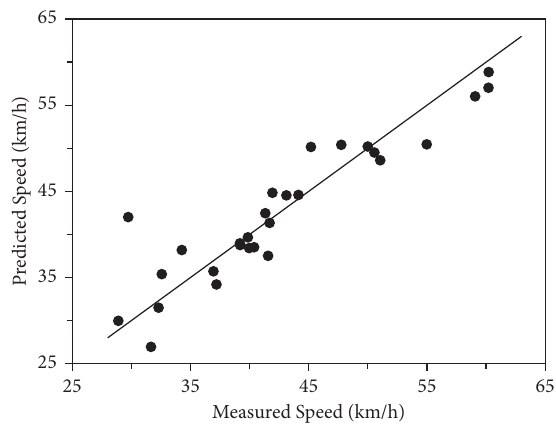
Figure 7: Comparison of the measured and predicted truck